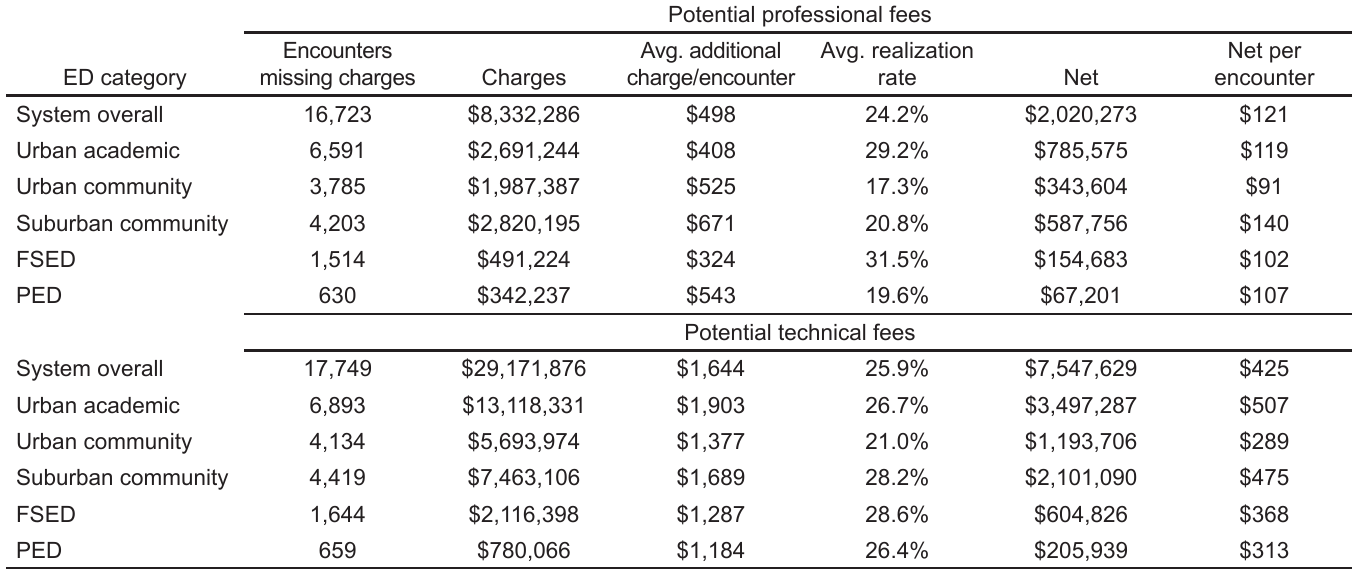
Table 4. Overall system and emergency department facility type comparison of potential professional and technical fees for patient who left before treatment was